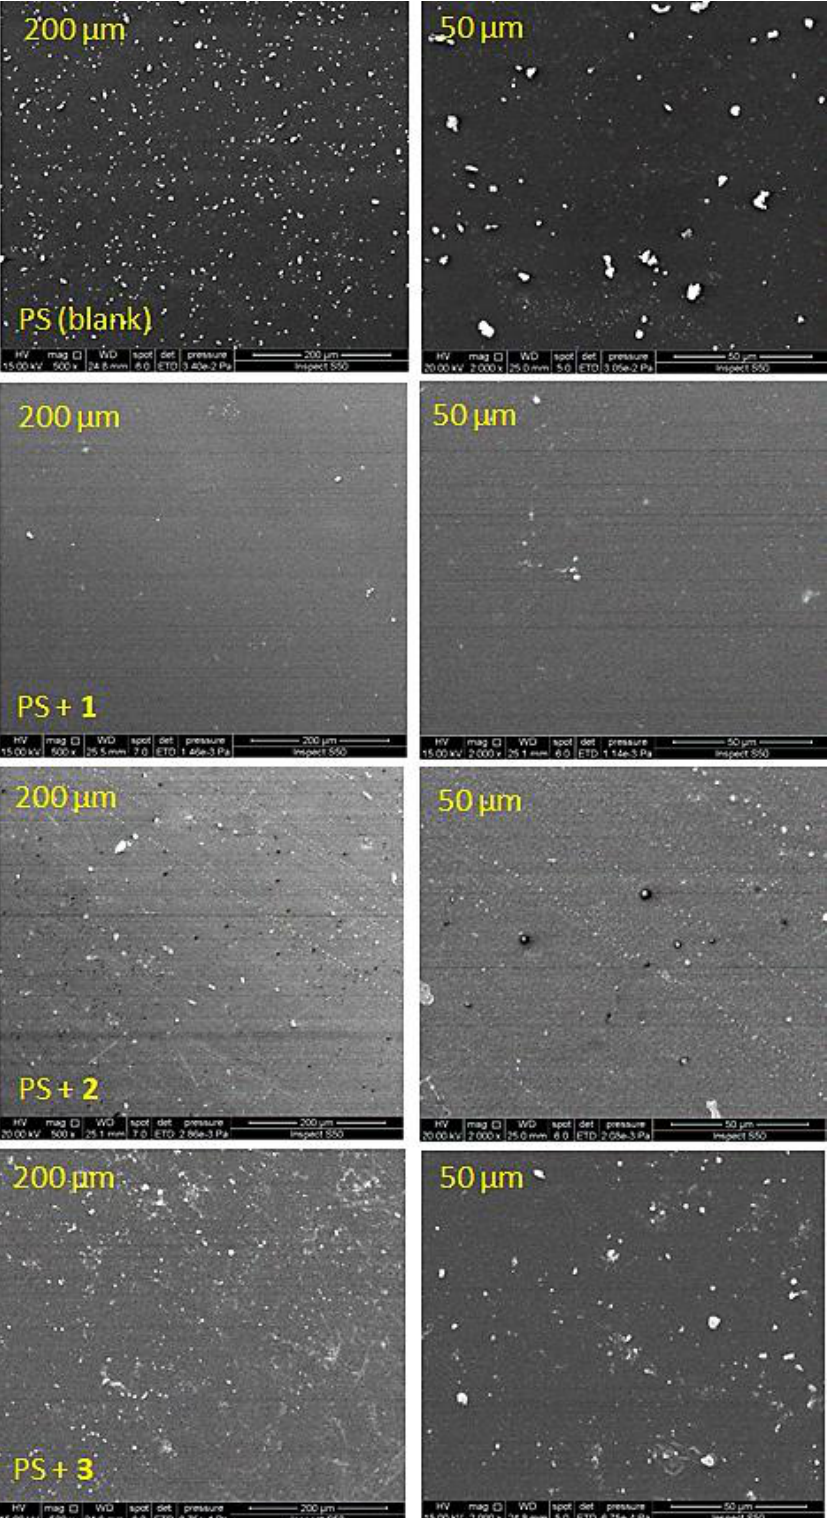
Figure 11. SEM images of PS and PS/Schiff bases 1 – 3 blends before irradiation.